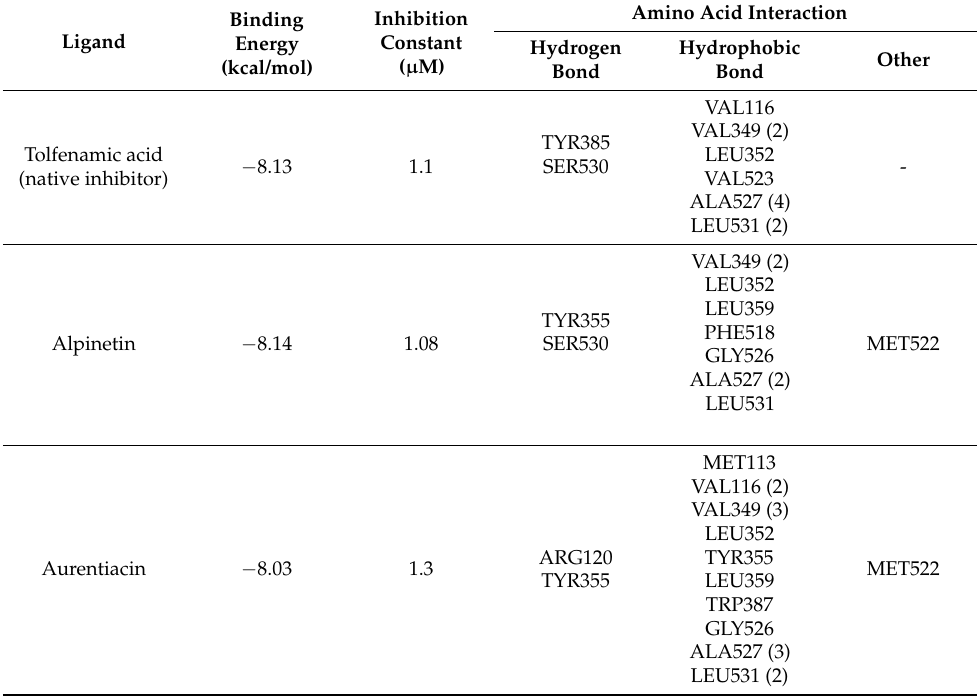
Table 4. Molecular docking results of top 5 identified compounds to COX-2 binding site .